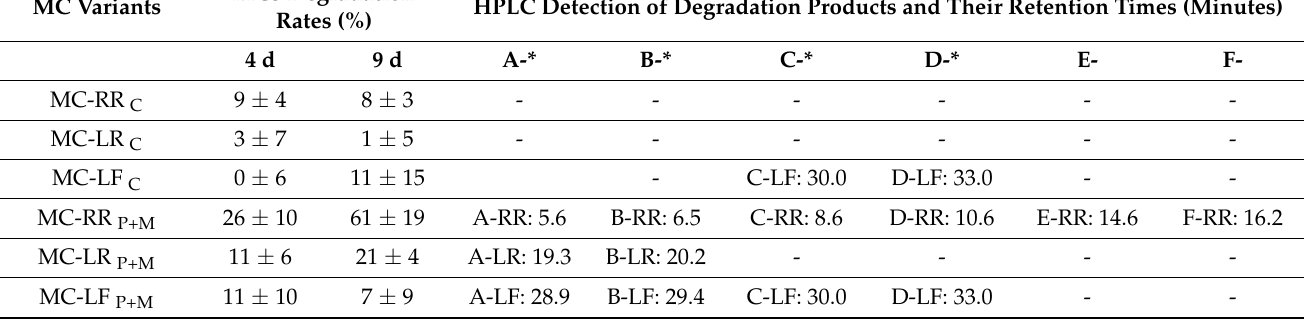
Table 1. Biodegradation of MC-RR, MC-LR, and MC-LF and the retention times of degradation products.